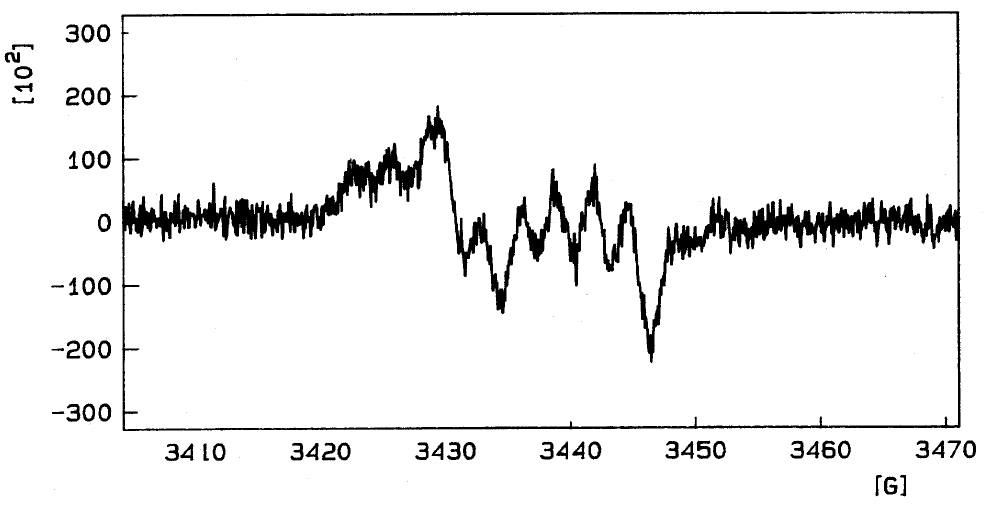
Figure 2: ESR spectra of compound 18 in